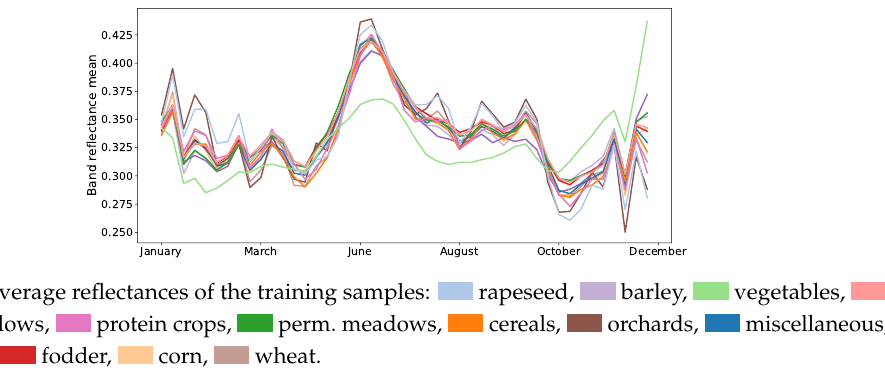
Figure 5. Average reflectances of the training samples: rapeseed, barley, vegetables, temp. meadows, protein crops, perm. meadows, cereals, orchards, miscellaneous, fallow, fodder, corn, wheat.